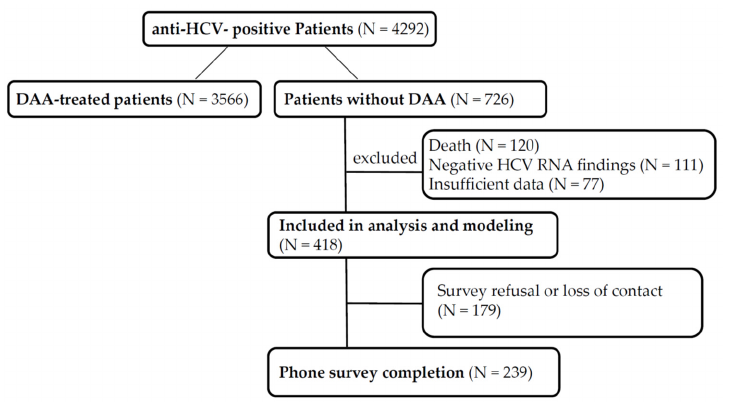
Figure 1. Flow diagram. DAA-treated patients were confirmed by records review, whereas patients without DAA were based on either phone confirmation of no desire to receive DAA or inability to reach the patient by phone. Table 1. Characteristics of patients with hepatitis C infection who have and have not received treatment. DAAs (N = 3566)